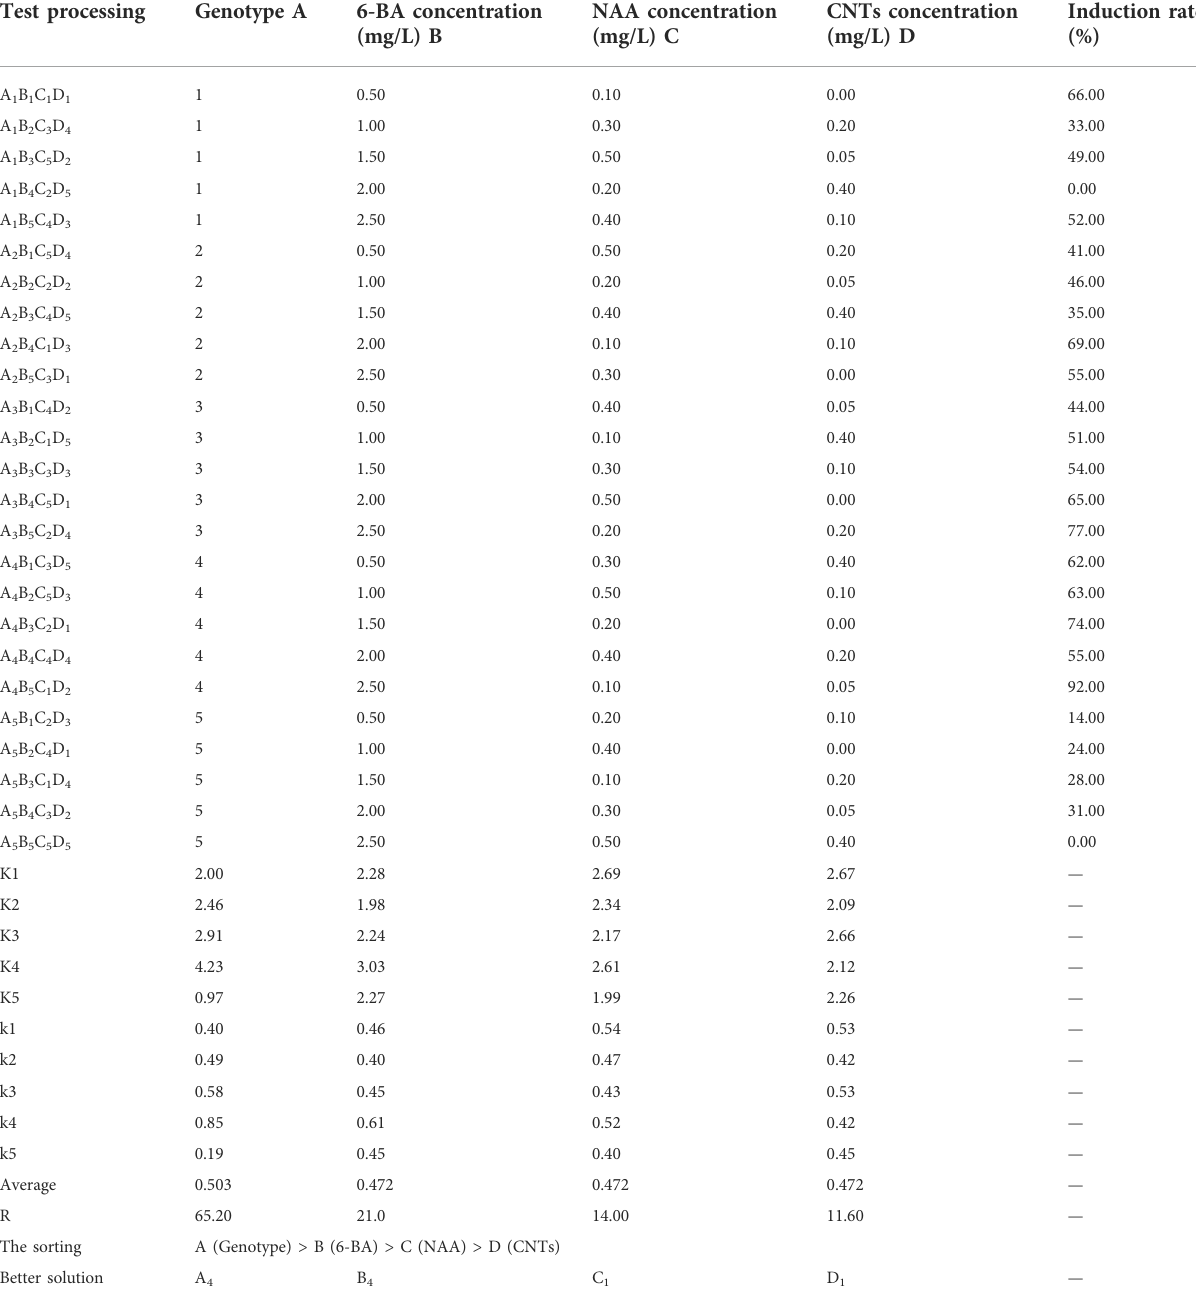
TABLE 1 Statistical result of orthogonal experimental design for callus induction from calla lily seed embryos. Test